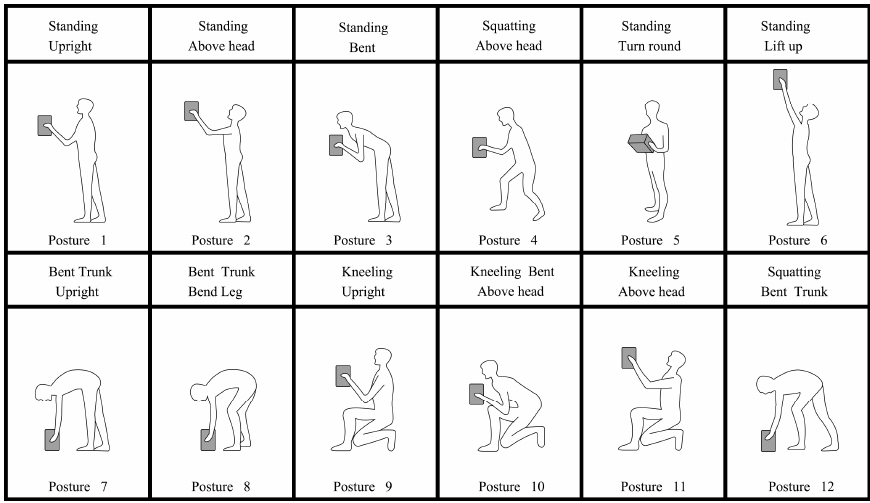
Figure 7. The 12 working posture using in the study.